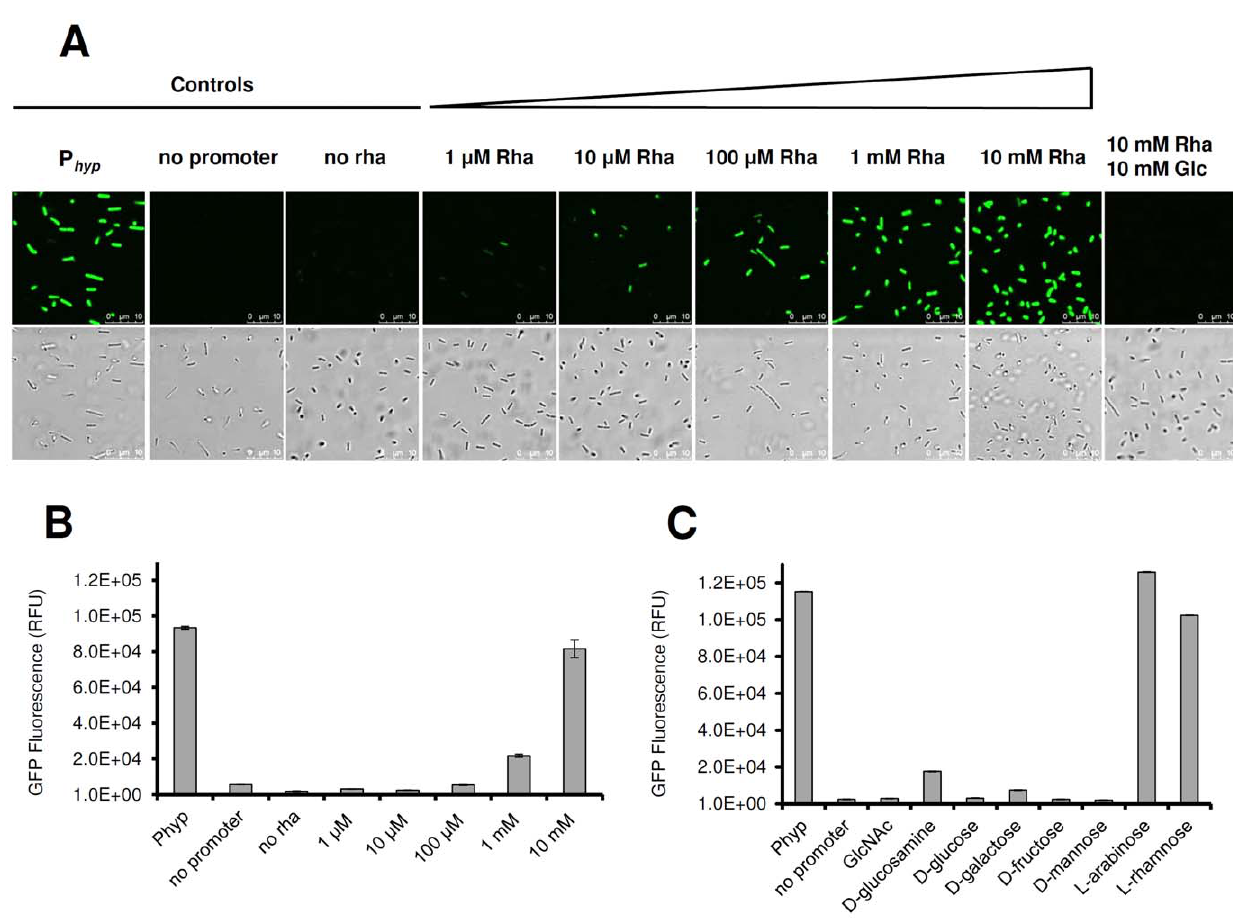
Figure 4. Rhamnose-inducible expression of GFP. Panels A and B: Dose-dependent response of P rha -controlled gfp expression in L. monocytogenes LF001 after 16 h of induction using rhamnose concentrations as indicated. Panel A, top row: fluorescence microscopy; bottom row, phase contrast microscopy. Positive and negative controls, and the effect of catabolite repression by addition of equimolar amounts of glucose and rhamnose are indicated. rha: rhamnose, glc: glucose. Panel B: quantitation of relative fluorescence (RFU) of GFP in rhamnose-induced bacteria. Positive (P hyp ) and negative (no promoter) controls are indicated on the left. Addition of 100 m M rhamnose increased fluorescence significantly (p , 0.001). Panel C: quantitative catabolite repression of P rha -dependent gfp expression in the presence of rhamnose together with a second carbohydrate (indicated on the x-axis), at equimolar concentration (10 mM). Positive (P hyp ) and negative (no promoter) controls are indicated on the